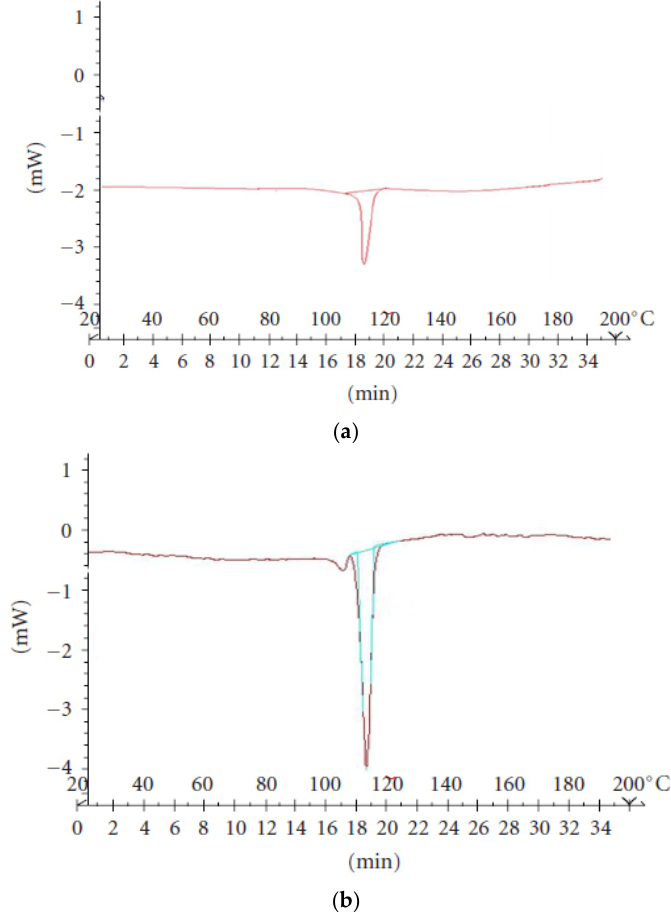
Figure 2. DSC thermogram of ( a ) pure VS and ( b ) physical mixture of VS. Table 2. Experimental runs projected and their responses